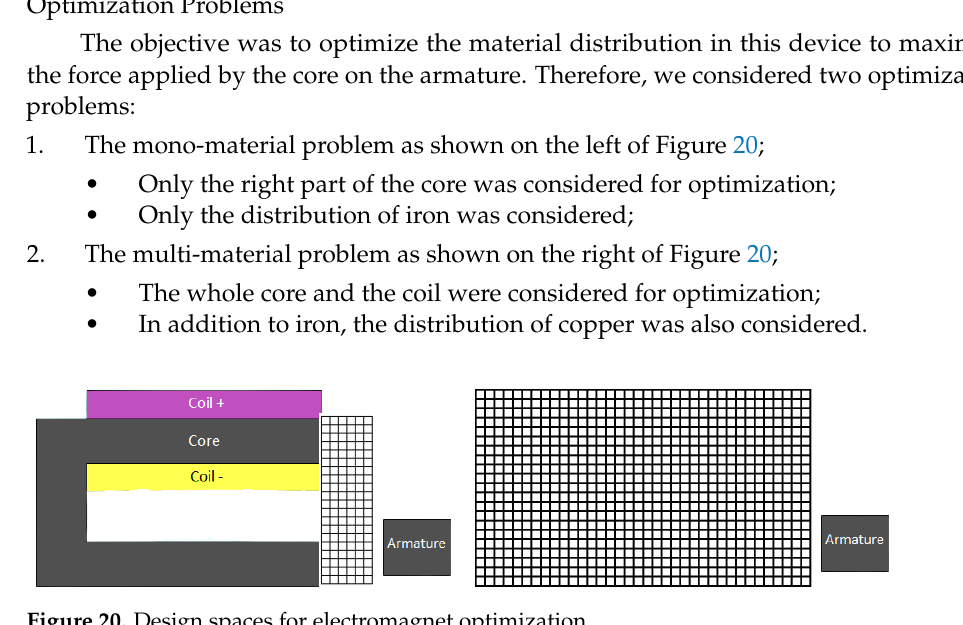
Figure 20. Design spaces for electromagnet